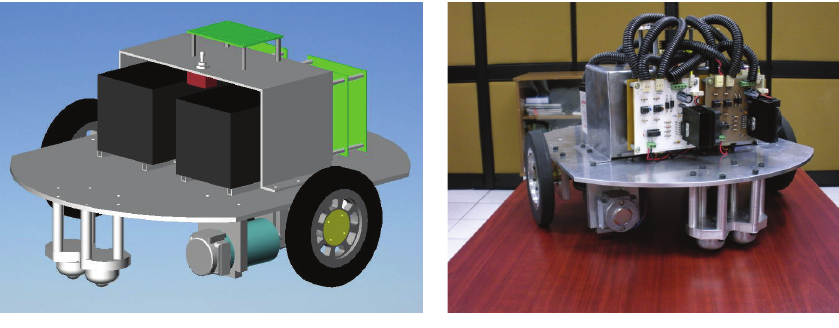
Figure 10: Block diagram of the power stage.